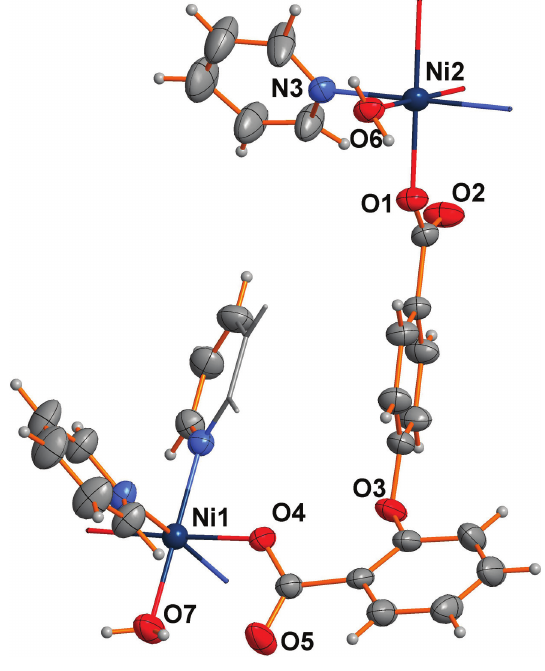
Table 1: Data collection and